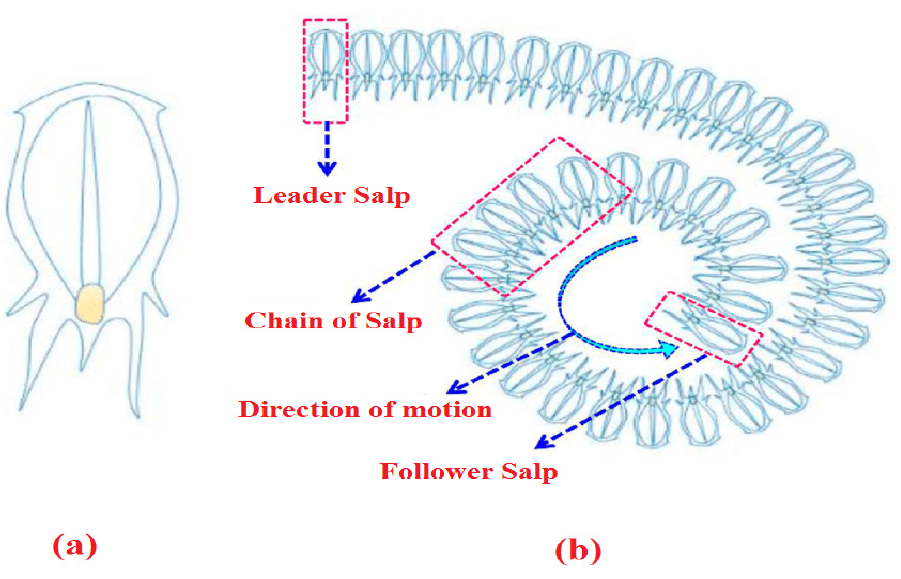
Figure 3. Single Salp ( a ); a group of Salps ( b ) [31].